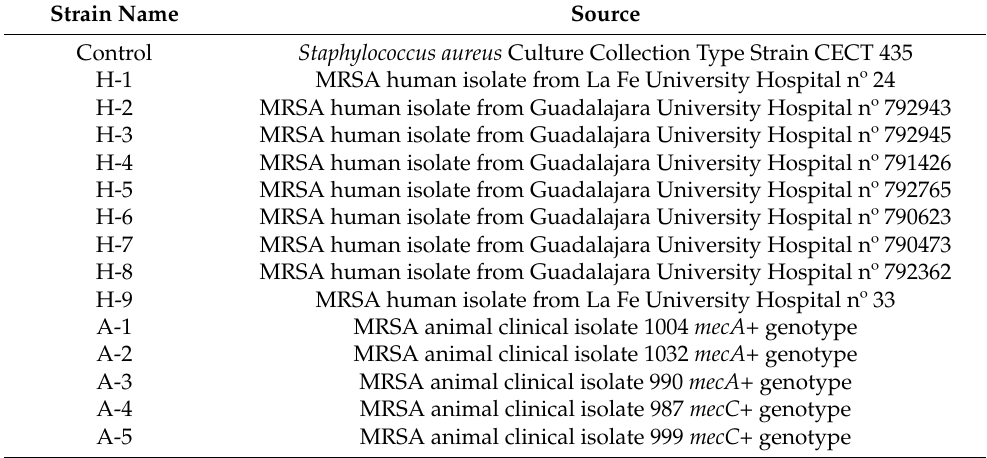
Table 1. S. aureus strains and sources used in this study. CECT= Colección Española de Cultivos Tipo (Spanish Culture Type Collection).